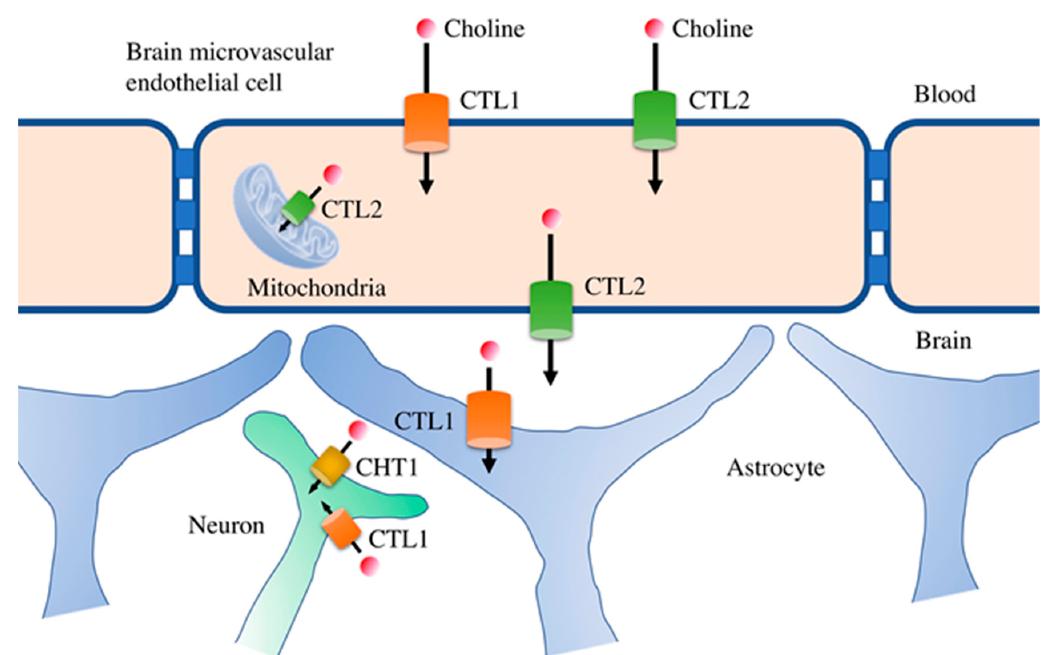
Figure 3. The localization of choline transporters in the blood–brain barrier. CTL1 and CTL2 are expressed in brain microvascular endothelial cells in the blood–brain barrier. Their localization on the luminal side of these cells suggests that they are responsible for the uptake of choline into the brain. CTL2 is also expressed on the apical side of brain microvascular endothelial cells, where choline is excreted into the brain. CTL1 is also expressed in astrocytes, one of the cell types that comprise the blood–brain barrier, and is thought to be linked to phospholipid synthesis. The high-affinity CHT1 and intermediate-affinity CTL1 are functionally expressed in neurons, where they may be involved in the synthesis of acetylcholine and phospholipids, respectively.